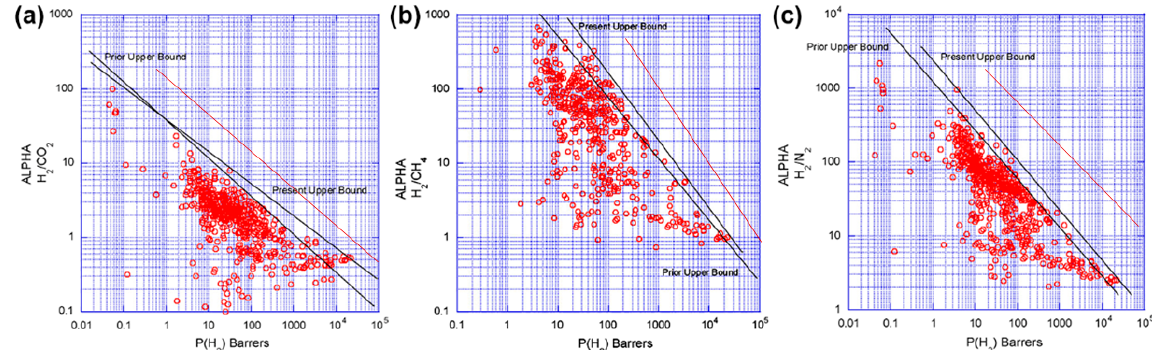
Figure 3. Robeson plot showing the present (2008) and prior (1991) upper bound for ( a ) H 2 /CO 2 , ( b ) H 2 /CH 4 , and ( c ) H 2 /N 2 gas pairs. Additional line in brown represents the most well-received upper bounds based on up-to-date profiles obtained from the following references [56–58] . Reprinted with permission from ref. [17] . Copyright 2008 Elsevier.